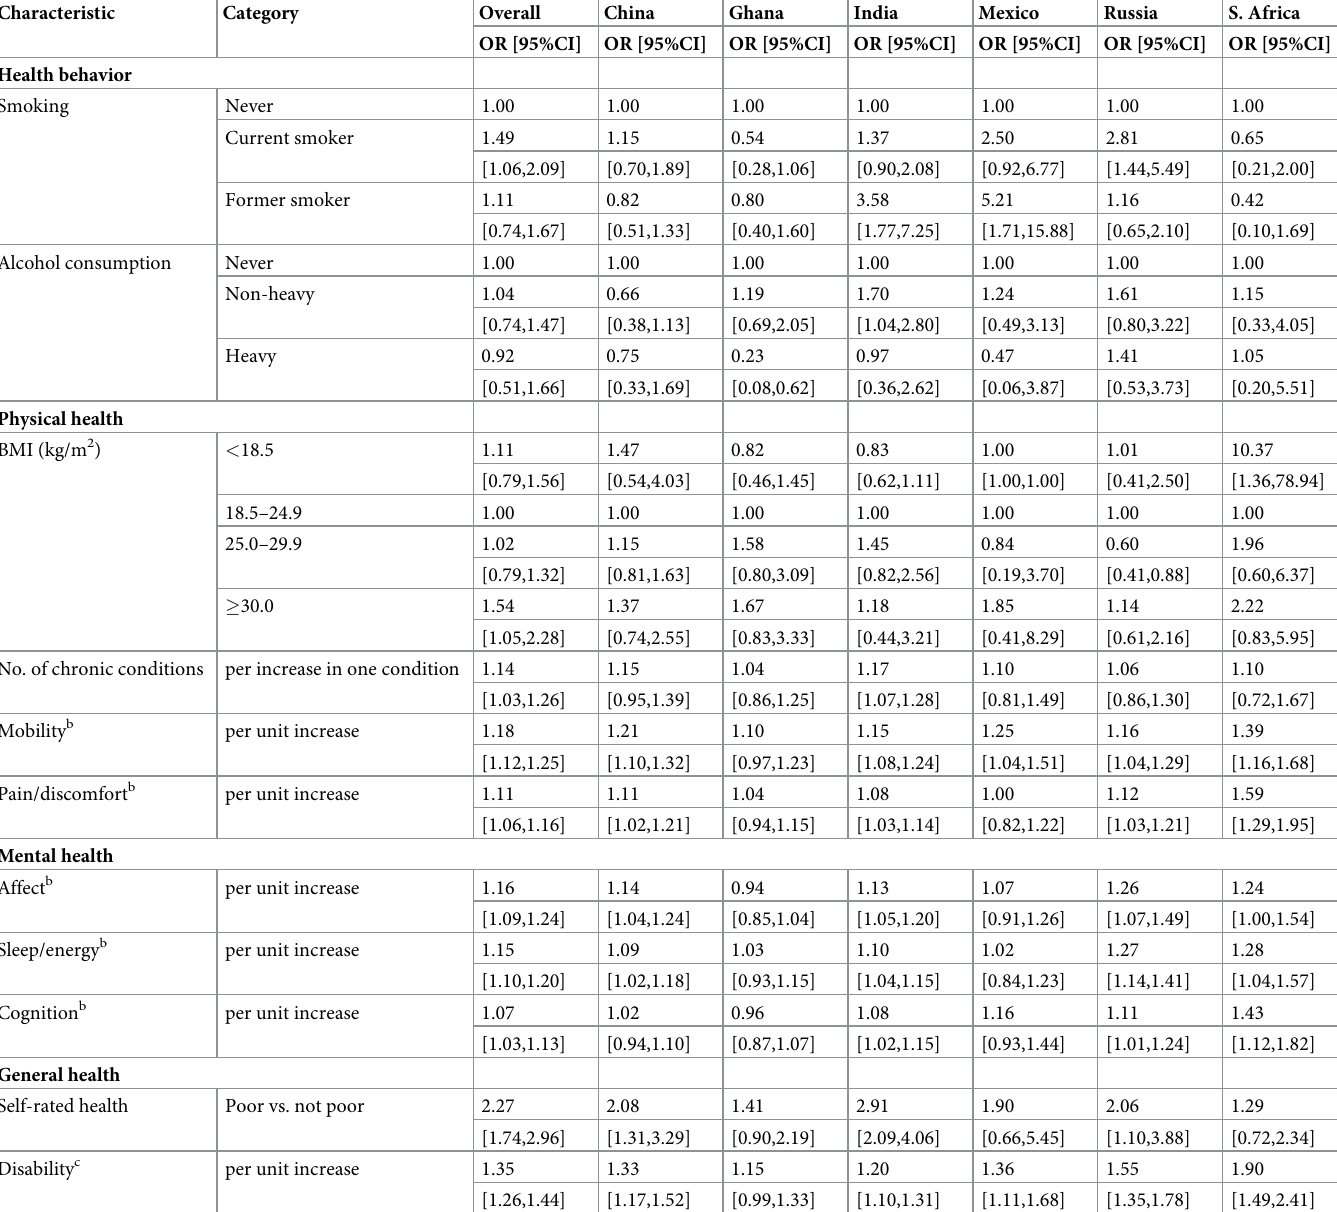
Table 3. Correlates (health behavior, physical health, mental health, general health) of highly sedentary behavior a estimated by multivariable logistic regression (overall and by country). Characteristic Health behavior